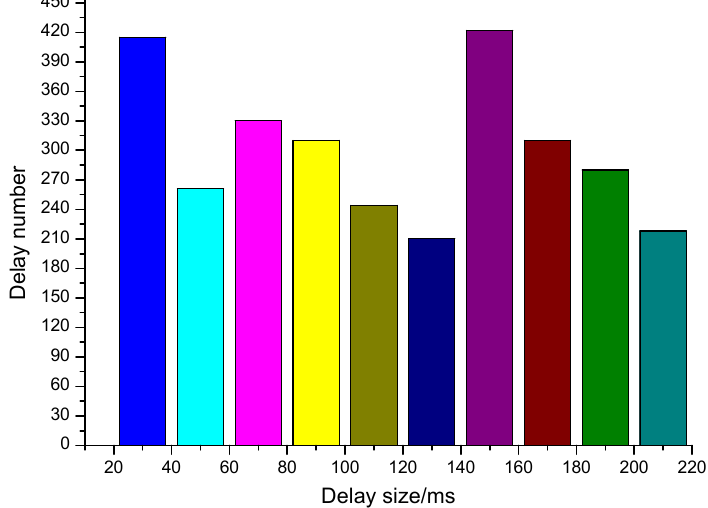
Figure 12. Time delay distribution before simulation of